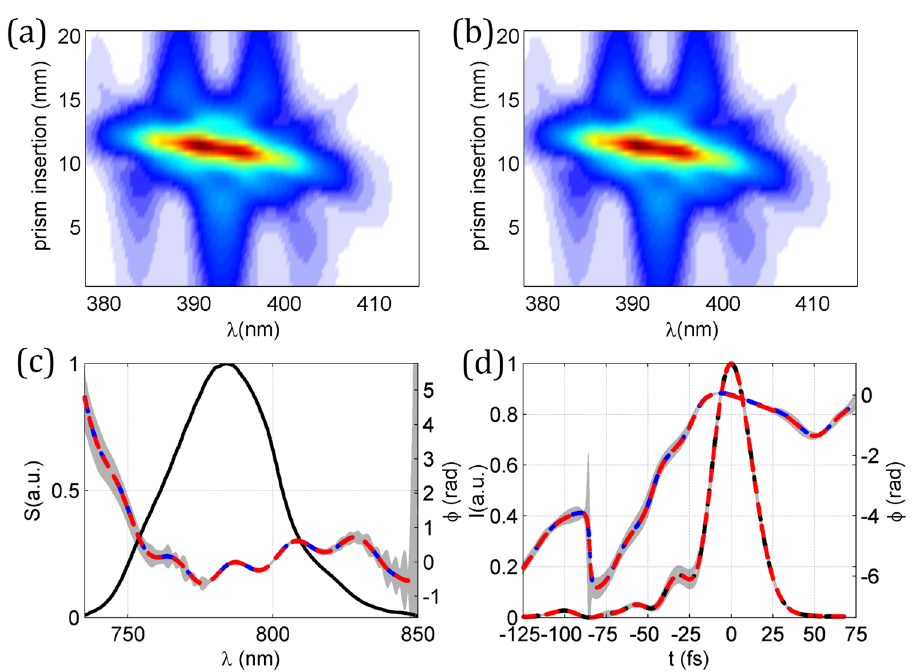
Figure 2. Example and statistics of the simulated self-calibrating d-scan retrievals. ( a ) Theoretical and ( b ) retrieved self-calibrating d-scan traces for GDD/L = 250 fs 2 /mm and TOD/L = 1000 fs 3 /mm (case 15 in Fig. 1). Statistics of the results of the 30 simulations with different GDD and TOD given in Fig. 1: ( c ) pulse spectrum (solid black curve) and retrieved phase (dashed blue curve: theoretical; dashed red curve: mean), ( d ) temporal intensity (dashed black curve: theoretical; dashed red curve: mean), and retrieved phase (dashed blue curve: theoretical; dashed red curve: mean). Grey shaded areas denote the error (magnified 10 times) in the retrievals, calculated as the standard deviation over the 30